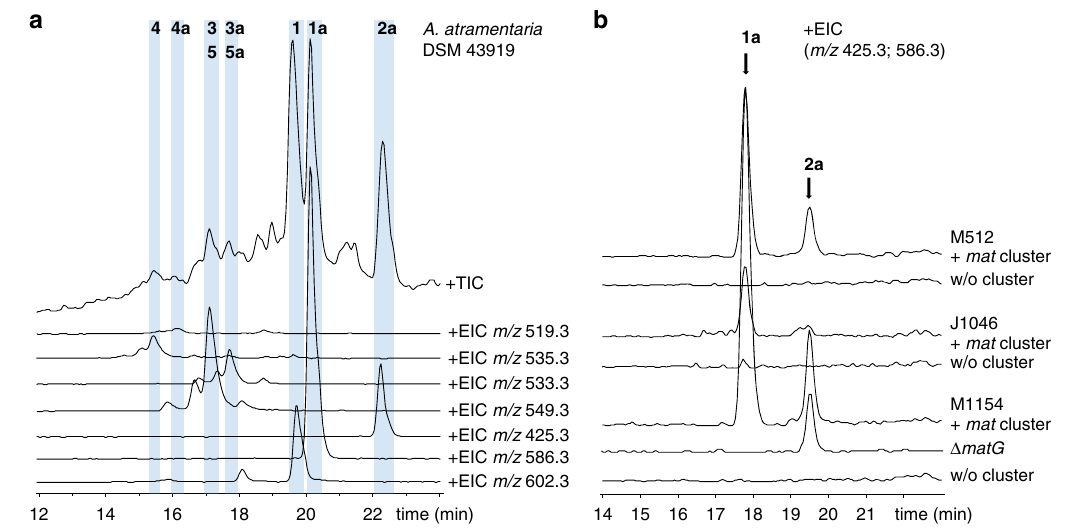
Fig. 3 LC-MS analysis for the detection of matlystatin derivatives in culture extracts. a Matlystatin production in extracts of A . atramentaria DSM 43919. b Heterologous production of deshydroxymatlystatins in Streptomyces species: S . coelicolor M512 (M512), S . albus J1046 (J1046), and S . coelicolor M1154 (M1154). All presented phenotypes of the mutants were reproducible in at least two other clones and one repeated independent